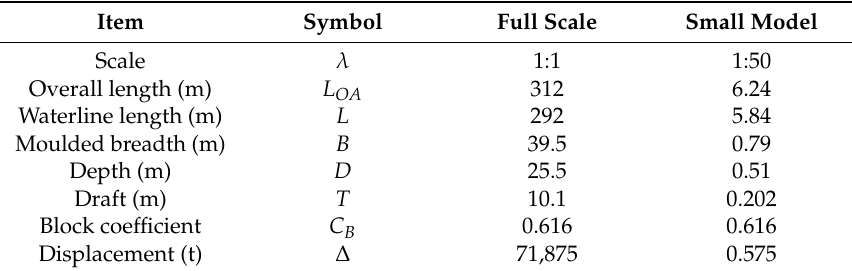
Table 1. Main dimension of the